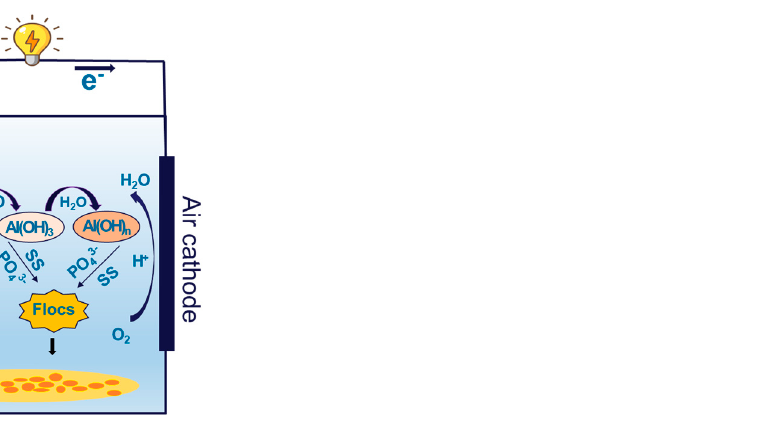
Figure 9. XRD patterns of floc precipitation in the aluminum–air fuel cell.